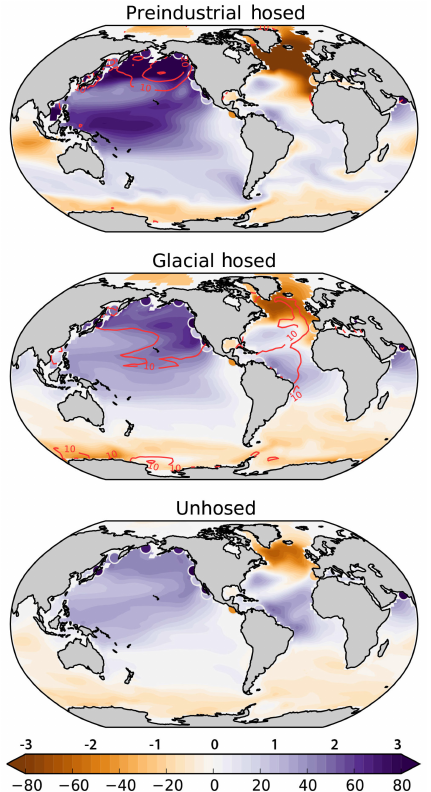
Figure 8. Stadial intermediate-depth (400–1100m) oxygen con- centration anomaly. The top two panels show the oxygen concentra- tion difference between weak and strong AMOC states (as defined in Fig. 3) under preindustrial and glacial boundary conditions, aver- aged between the four sets of orbital configurations (see Fig. S7 to view all eight hosing simulations individually). Red contours show the standard deviation between the four sets of orbital configura- tions at 1µmolkg − 1 intervals. The bottom panel shows the oxygen concentration difference between weak and strong AMOC states (as defined in Fig. 3) in the unhosed simulation. Markers represent the first principal component of the detrended time series for ben- thic oxygenation proxies compiled by Galbraith and Jaccard (2015). Shading and contours in µmolkg − 1